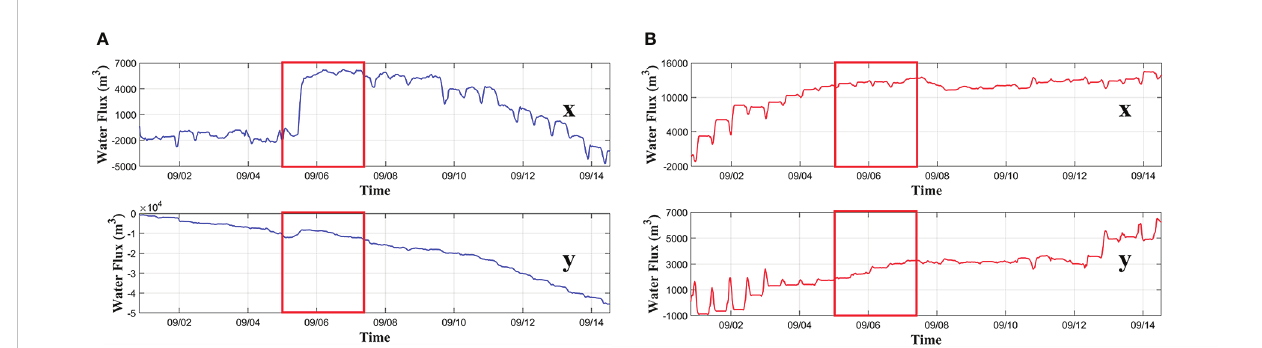
FIGURE 10 Time series of water fl uxes at station S1 (A) and S2 (B) (red box indicates typhoon